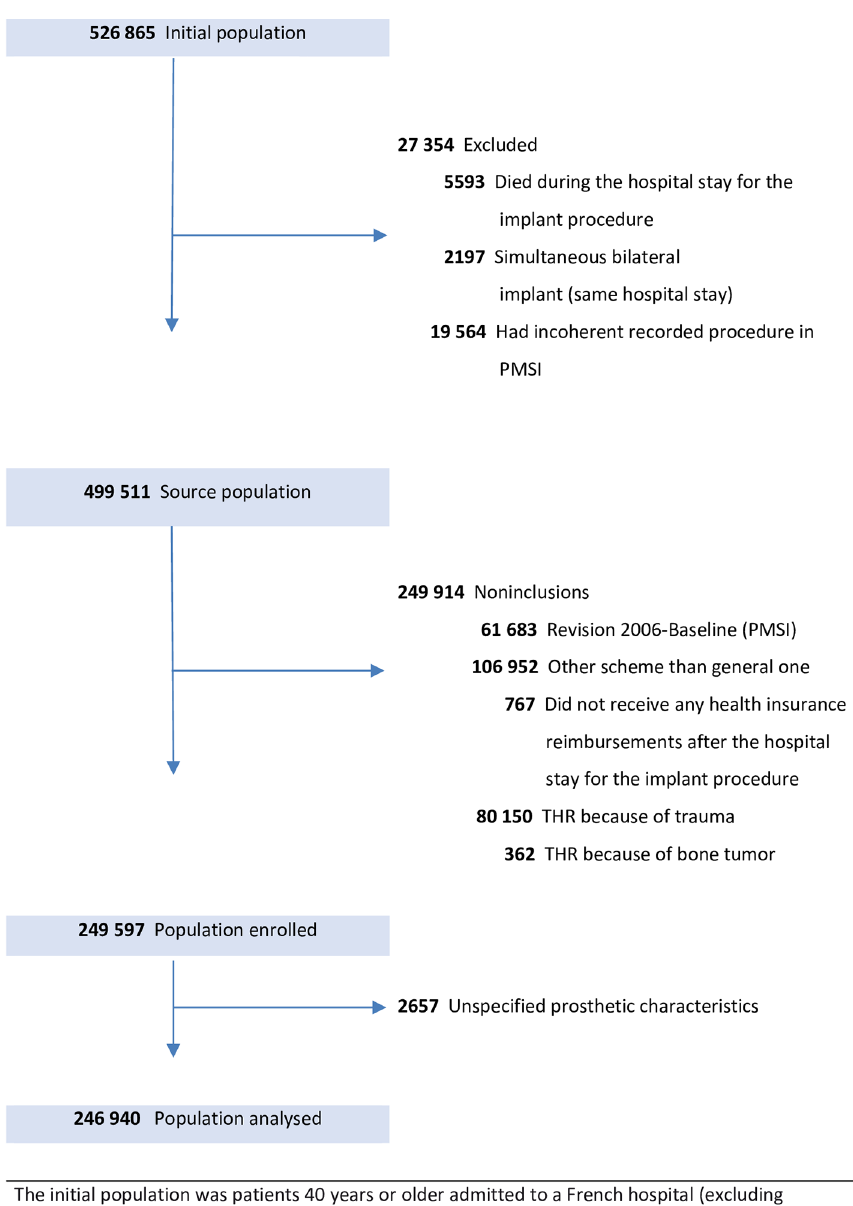
Fig 1. Study population